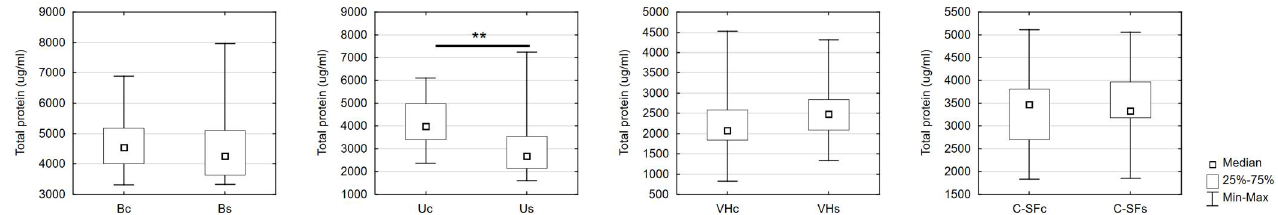
Figure 4. Protein assay in the control and the study group in biological fluids. Bc, blood of the control group; Bs, blood of the study group; C-SFc, cerebrospinal fluid in the control group; C-SFs, cerebrospinal fluid in the study group; Uc, urine of the control group; Us, urine of the study group; VHc, vitreous humor of the control group; VHs, vitreous humor of the study group; ** p < 0.01 vs. control.